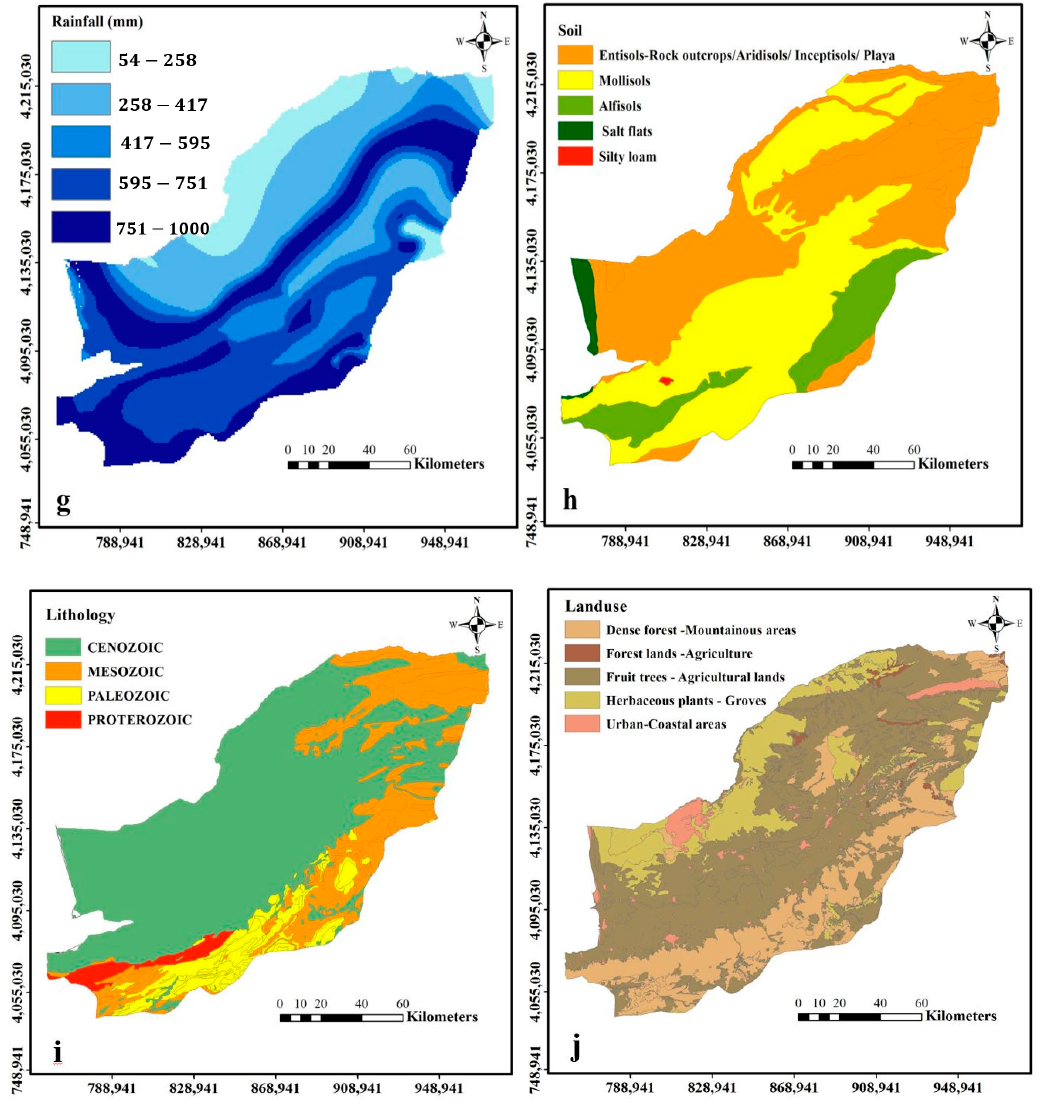
Figure 3. Different flood influential criteria: ( a ) altitude ( b ) slope ( c ) aspect ( d ) plan curvature ( e ) distance from rivers ( f ) TWI ( g ) rainfall ( h ) soil type ( i ) lithology ( j ) land use.